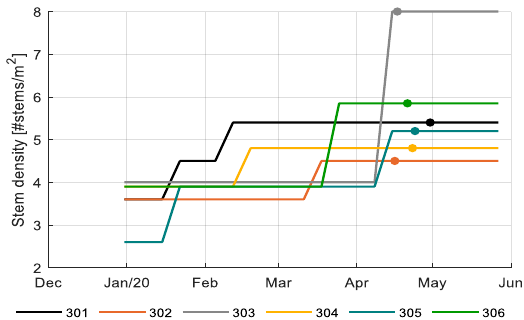
Figure 14. Stem density (# stems / m 2 ) and topping dates (-o-) in di ff erent greenhouse compartments (301–306).